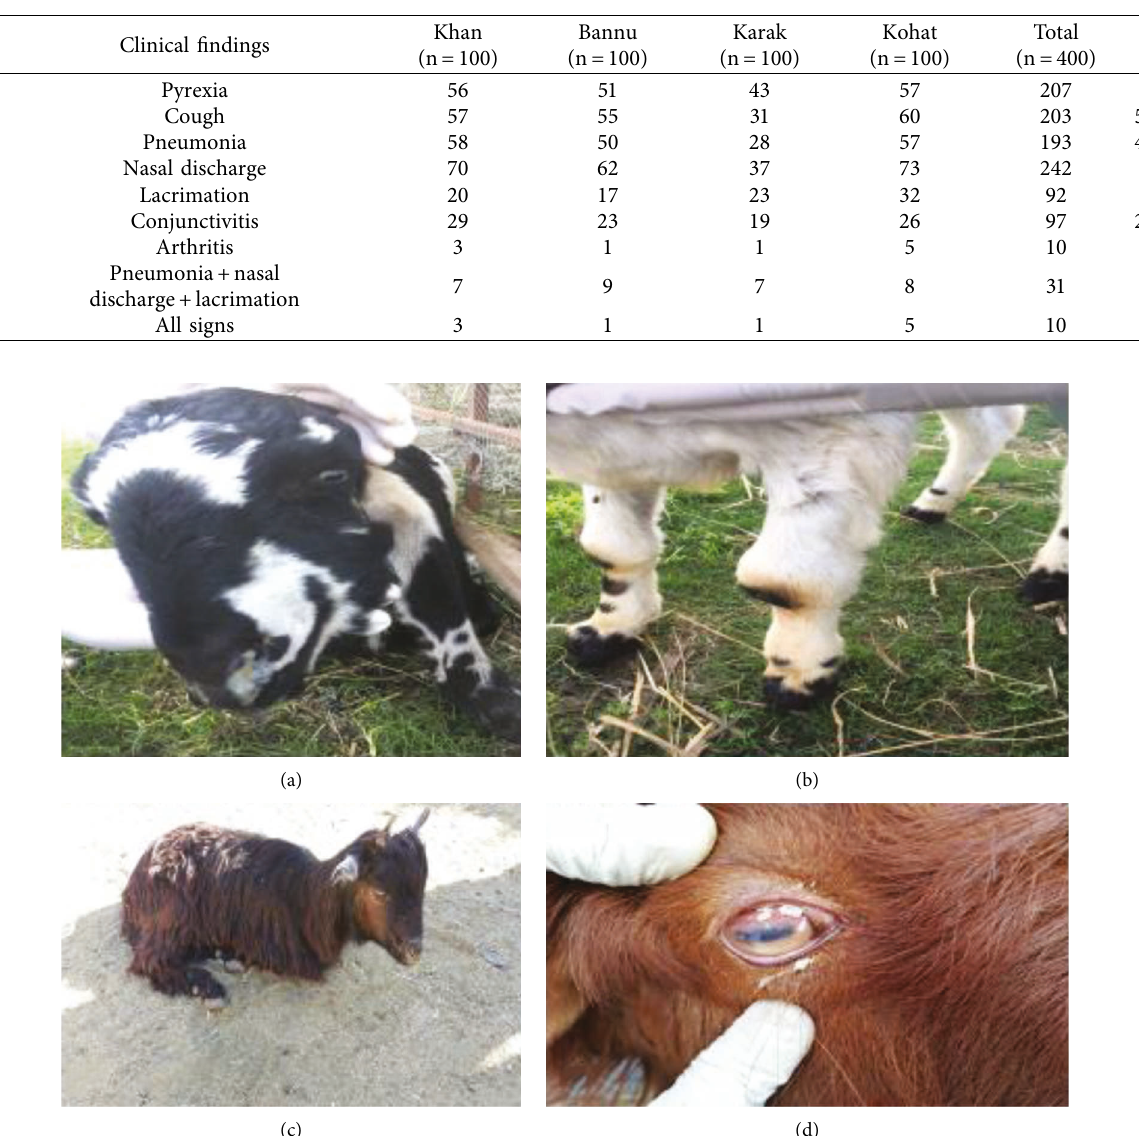
Figure 5: (a) Nasal discharge and lacrimation. (b) Synovial joint swelling. (c) Nasal discharge, lacrimation, and fever. (d)